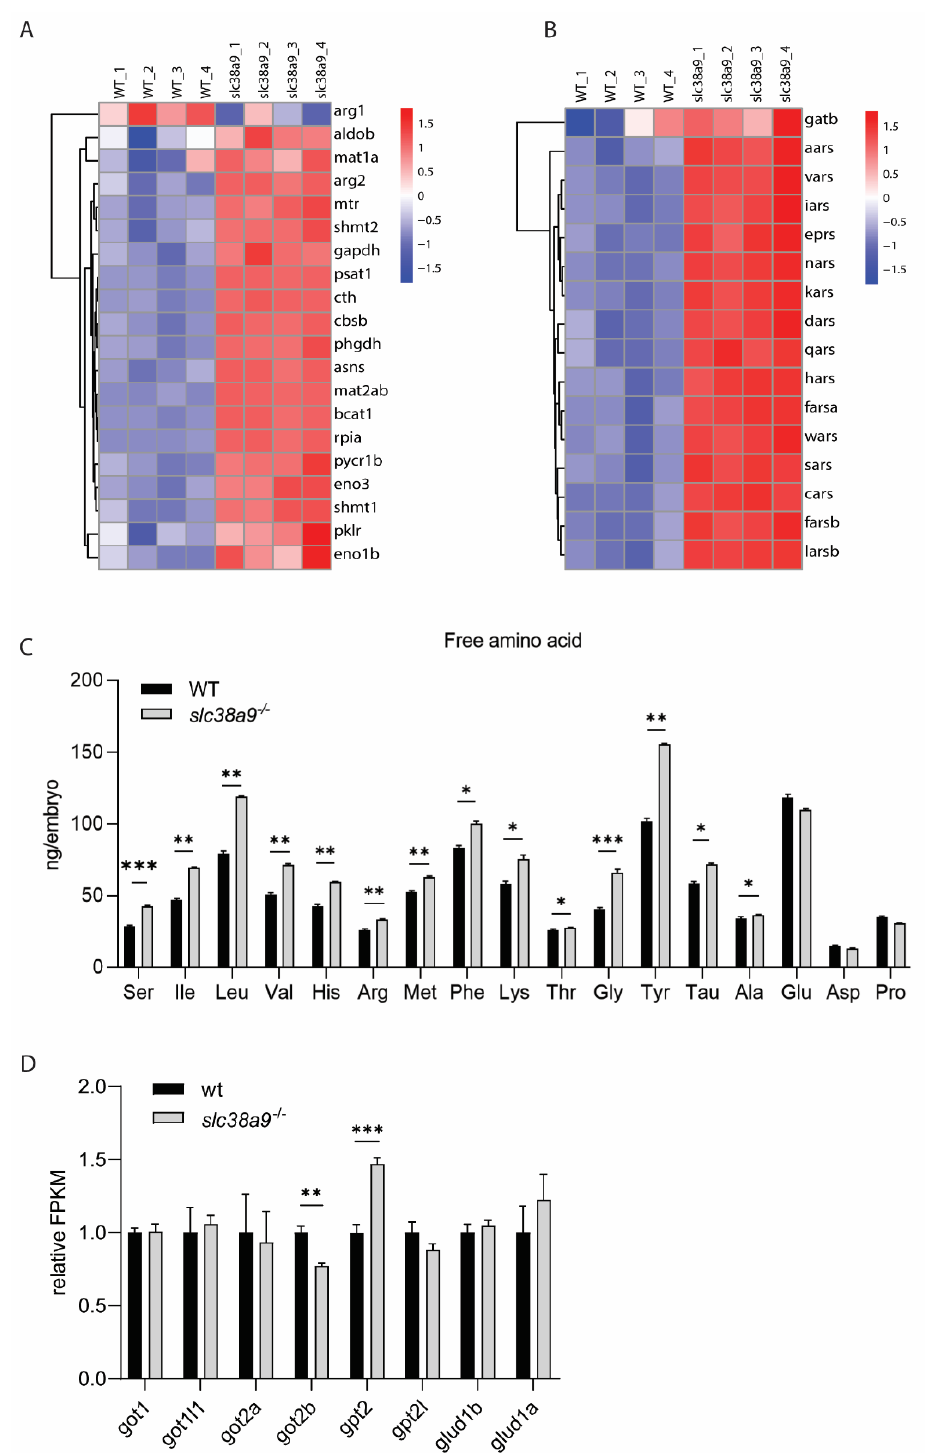
Figure 5. Biosynthesis of amino acids and aminoacyl-tRNA were enhanced in slc38a9 −/− embryos. ( A ) Heatmaps of transcripts in the biosynthesis of amino acids ’ enrichment. ( B ) Heatmaps of transcripts in aminoacyl-tRNA synthetases ’ enrichment. ( C ) Most free amino acids (FAAs) increased in slc38a9 −/− mutants. The contents of most FAAs (Leu, Met, Ile, Val, Lys, etc.) increased except for Pro, Glu, and Asp. The profile of FAAs was measured using the automated amino acid analyzer. ( D ) The relative FPKM of major aminotransferases in WT and slc38a9 mutant zebrafish embryos (60 hpf). Data shown are mean ± SEM, n = 3. * p < 0.05, ** p < 0.01, *** p < 0.005.